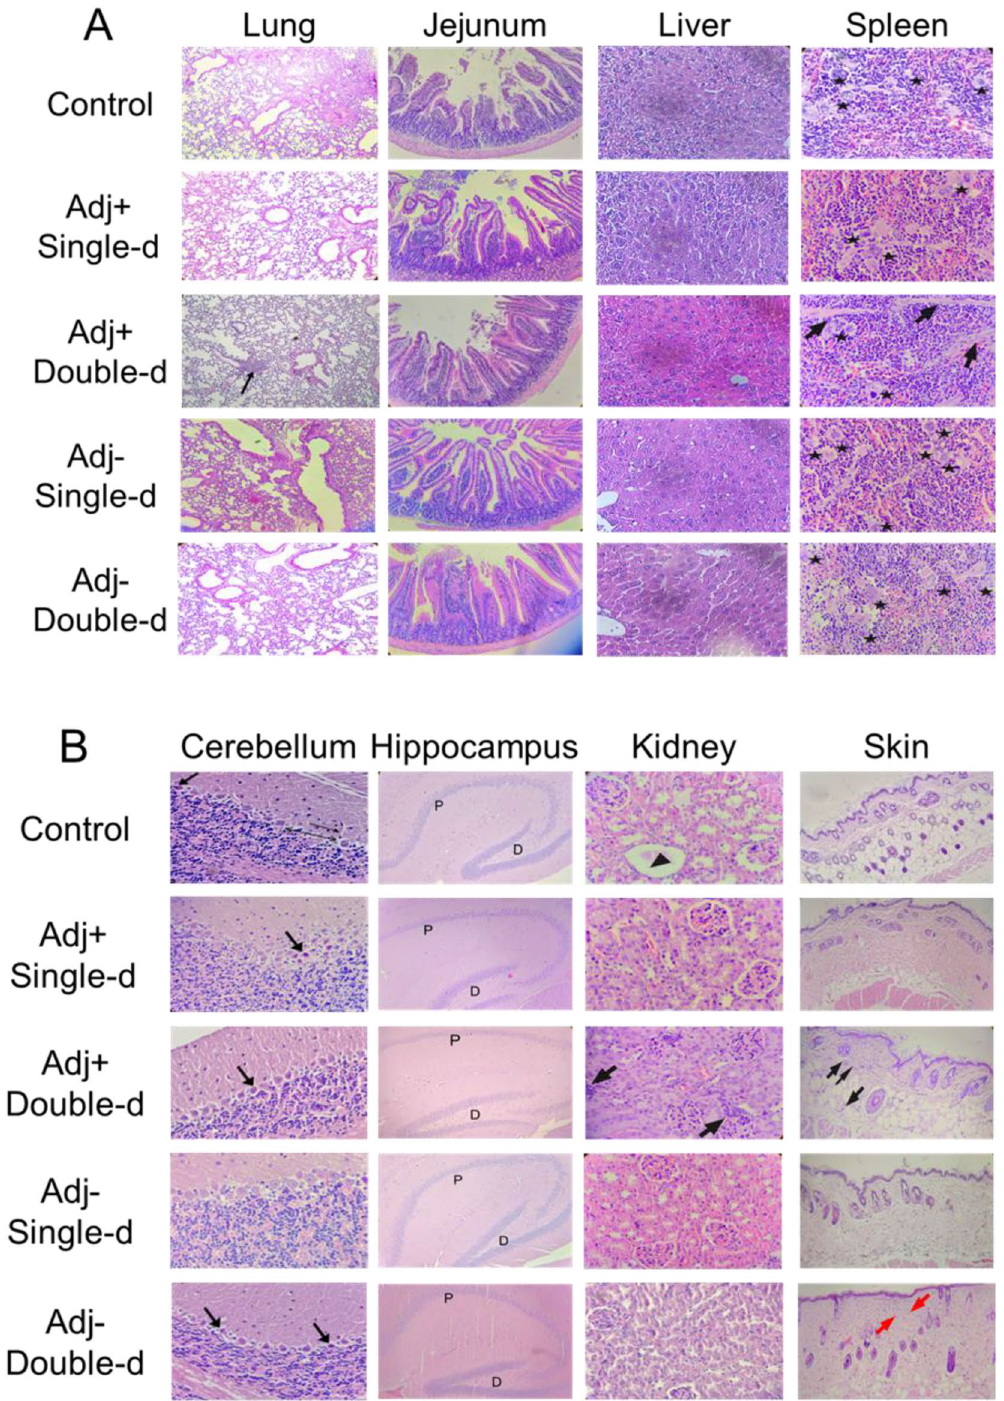
Figure 6. Day-21 safety analysis of the vaccine candidates, SK-01 V1, and OZG-3861 V1. Histopathologic analysis on day 21 of ( A ) lung (the arrow; chronic inflammation X100), jejunum of the intestine, liver, spleen, and ( B ) cerebellum of brain, hippocampus, kidney, and skin. In the spleen, stars show foci of megakaryocytes and arrows were trabeculae (X400 H + E stain). In the cerebellum, the thin arrow shows dendrites, the thick arrow shows picnotic cell, the thin double-headed arrow shows space. In the hippocampus, P is the pyramidal cell layer and D is the dentate gyrus (X100 H + E stain). In the kidney, the arrow shows interstitial chronic inflammation (X400 H + E stain). In the skin, black arrows show infiltrated inflammatory cells and red arrows show eosinophils (X40 H + E stain). ( C ) Bar graphs showing quantitated mouse cytokine bead array analysis by assessing Th1, Th2, and Th17 specific cytokines (picogram/ml) in mice serum collected on day 21 of the vaccine